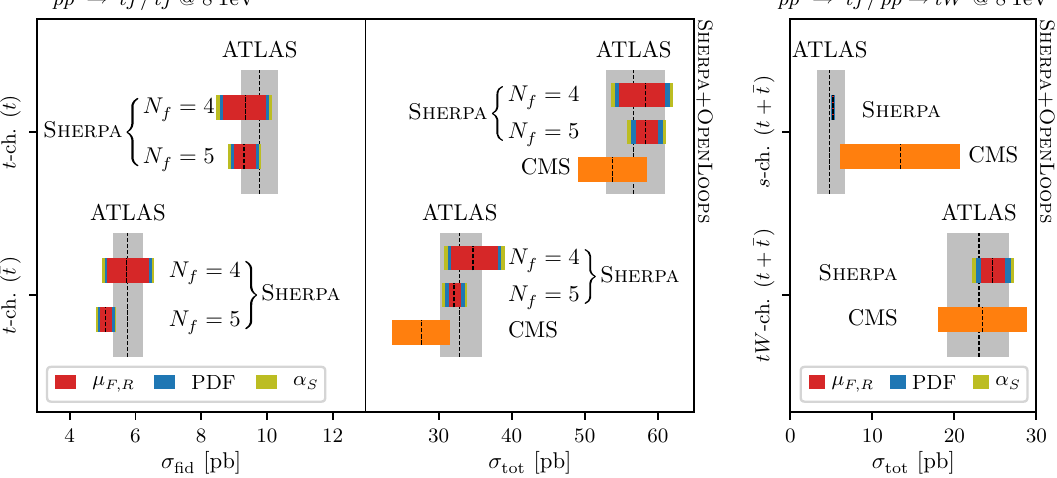
Fig. 1 Depiction of the cross sections from Table 4. The uncertainties for the S HERPA results are displayed staggered, i.e. the total width of the S HERPA band corresponds to the scale uncertainty (red), the PDF uncertainty (blue) and the α s uncertainty (yellow) added linearly. Only